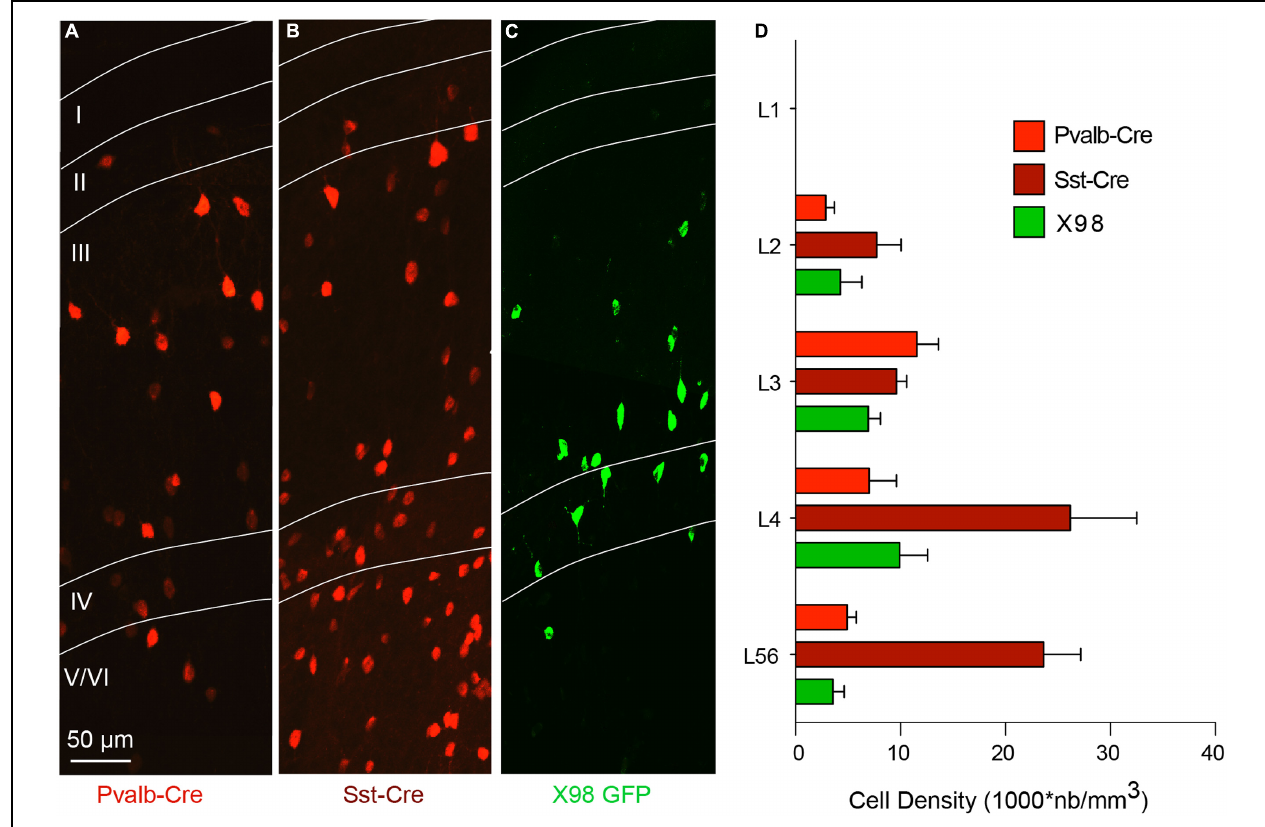
FIGURE 2 | Layer-specific distribution of presubicular interneurons in three mouse lines. (A–C) show horizontal sections of presubiculum, with fluorescently labeled neurons from the Pvalb-Cre line (A) , the Sst-Cre line (B) , both with maternal cre inheritance and tdTomato as reporter (red), and GFP +